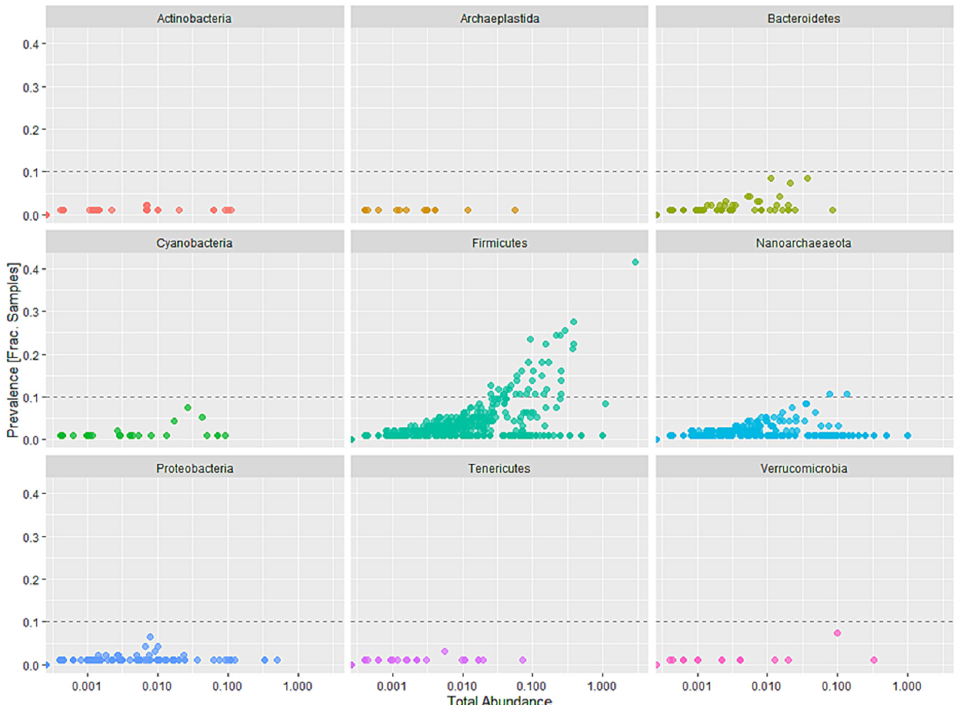
Figure 1. Prevalence of the most dominant phyla as observed across all the four dietary treatments. Prevalence shown is in relation to the total abundance counts.